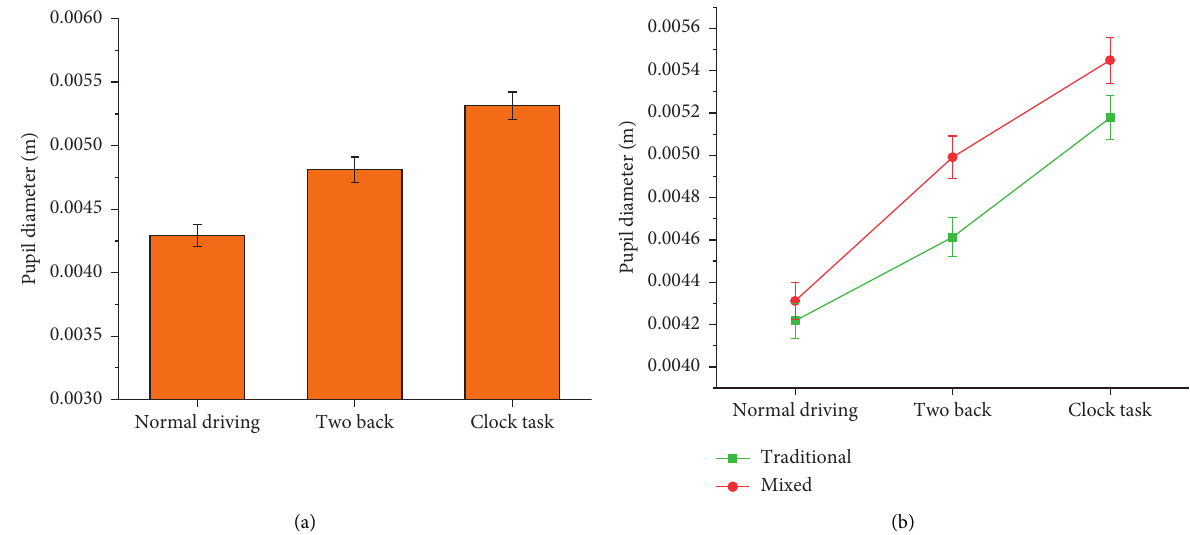
Figure 6: (a) Main effect of the driving tasks on the pupil diameter. (b) Interaction effect of the driving tasks and traffic environment on the pupil